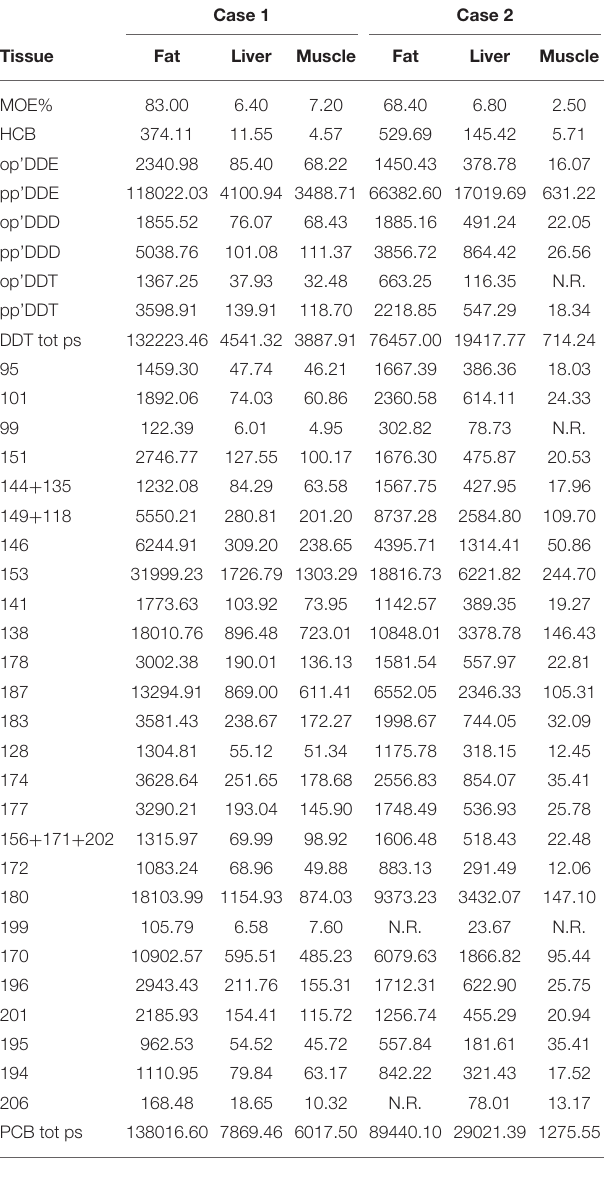
TABLE 1 | Extracted organic material (EOM %) and organochlorine contaminants (HCB, DDT e PCB) in sampled tissues from both cases, expressed in ng/g dry weight